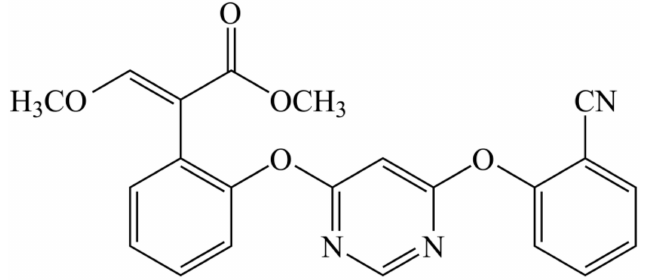
Figure 1. Molecular structure of